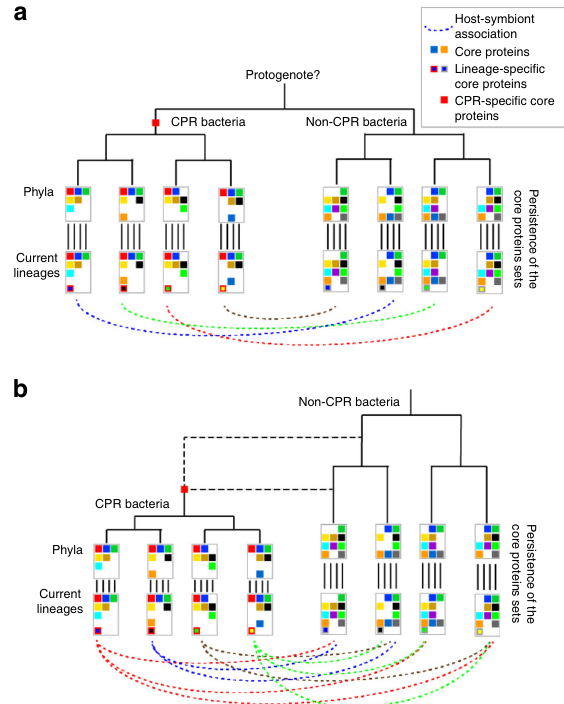
Fig. 7 Two scenarios for the origin and the evolution of the CPR. a In the fi rst scenario, CPR and non-CPR bacteria emerged from the protogenote community and co-evolved. In this case, major divergences within the CPR, essentially the rise of new CPR phyla, may have been stimulated by evolutionary innovations that generated new lineages of potential bacterial hosts. b In the second scenario, CPR evolved from within the non-CPR bacteria and experienced a huge genome